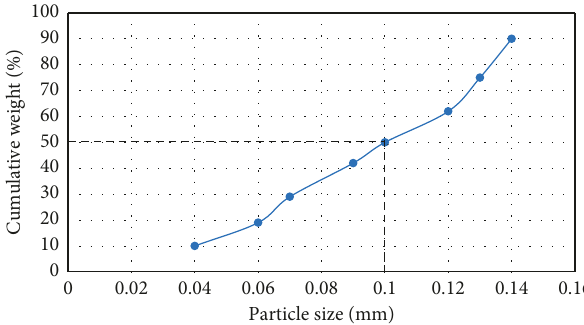
Figure 17: Particle size distribution (PSD) of concentric and stationary inner pipe with 5% inlet sand concentration and 0.1mm average particle